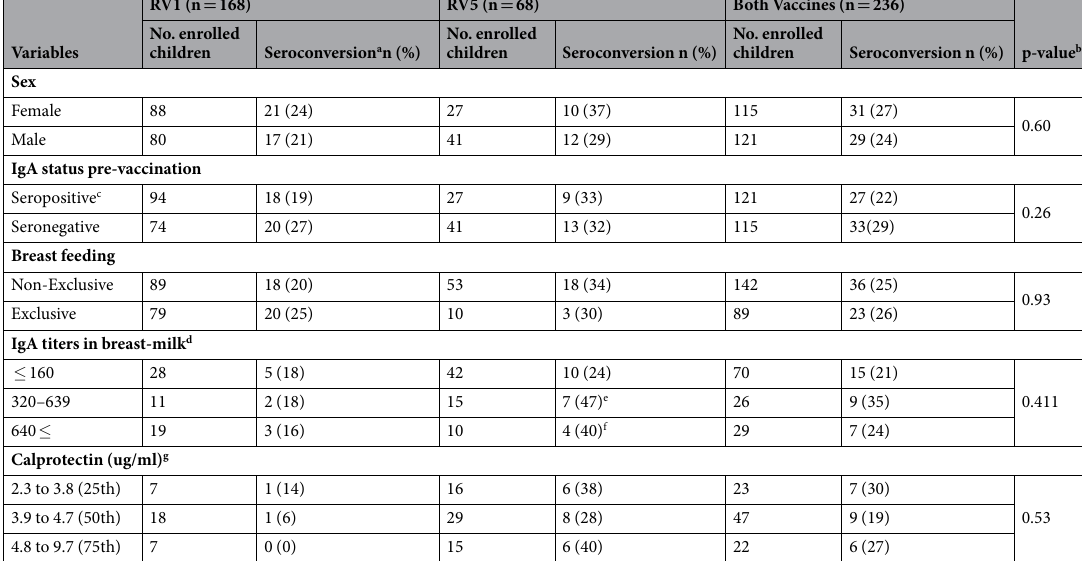
Table 3. Association between non-genetic characteristics and IgA seroconversion among vaccinated Nicaraguan children. a Seroconversion defined as a four-fold increase in serum IgA titers 28 days post- vaccination with RV1 or RV5. b Chi-square test of equal proportions for both vaccines combined c Seropositivity was defined as a titer of IgA ≥ 80 or ≥ 100 in RV1 or RV5, respectively. d A subset of 58 RV1 and 67 RV5 mothers provided breast milk for IgA analysis. Titer categories were arbitrary defined. e OR = 2.8, CI: 0.81–9.66, after comparing ≤ 160 vs 320–639 categories, respectively f OR = 2.1, 0.50–9.10, after comparing ≤ 160 vs 640 ≤ categories, respectively g A subset of 32 RV1 and 60 RV5 children provided stool samples for calprotectin analysis. Stratification of calprotectin concentration represent percentiles. Abbreviations: RV1 = monovalent rotavirus vaccine; RV5 = pentavalent rotavirus